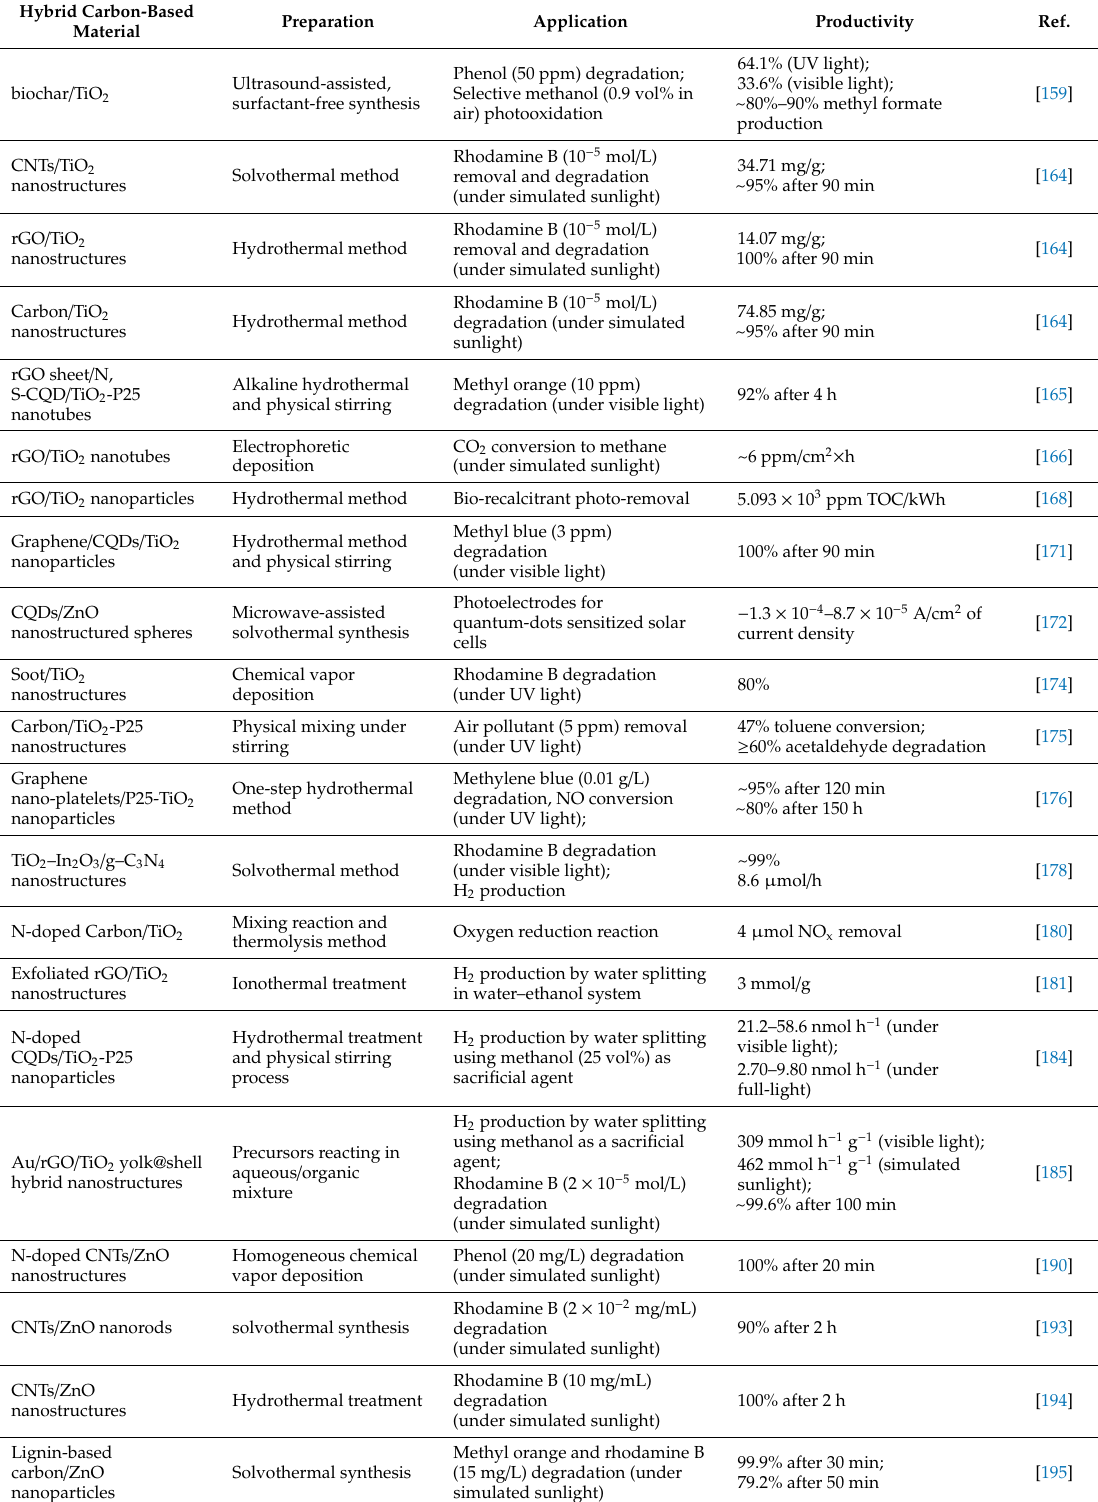
Table 4. Carbon-based hybrid nanomaterials and their photocatalytic activity data under visible irradiation or solar light irradiation. The best results achieved in each work are